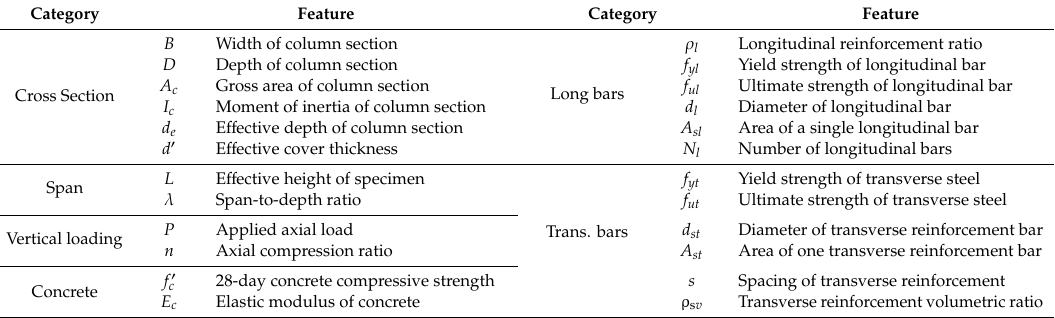
Table 1. Features of reinforced concrete (RC)